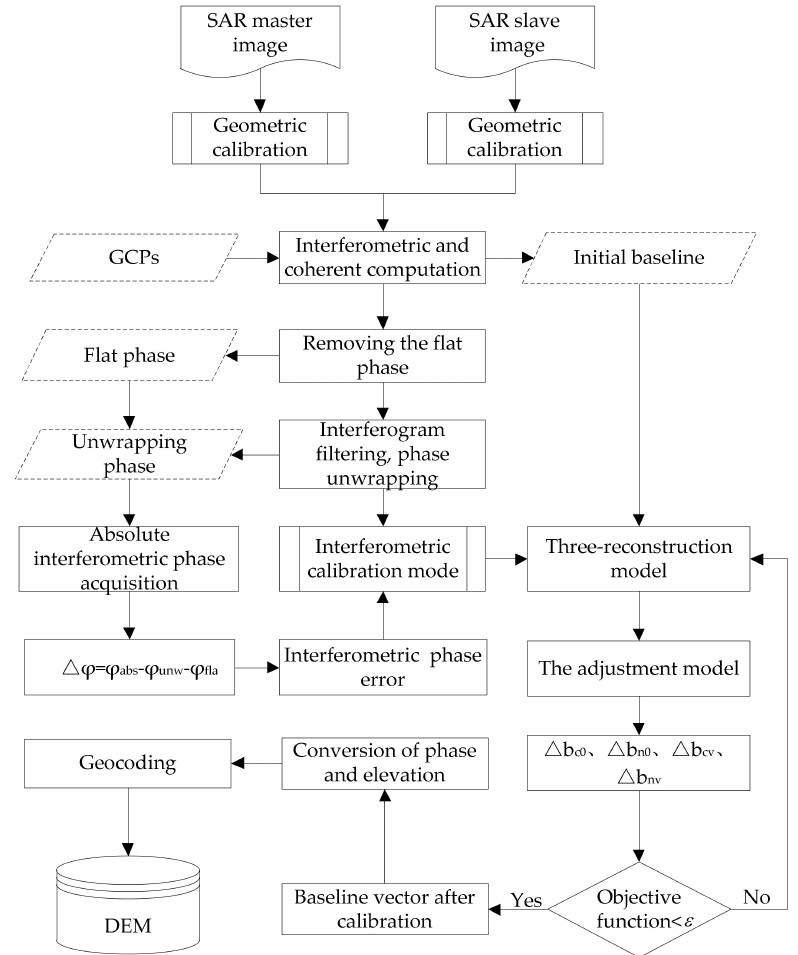
Figure 2. Methodological flow of the spaceborne SAR interferometric calibration